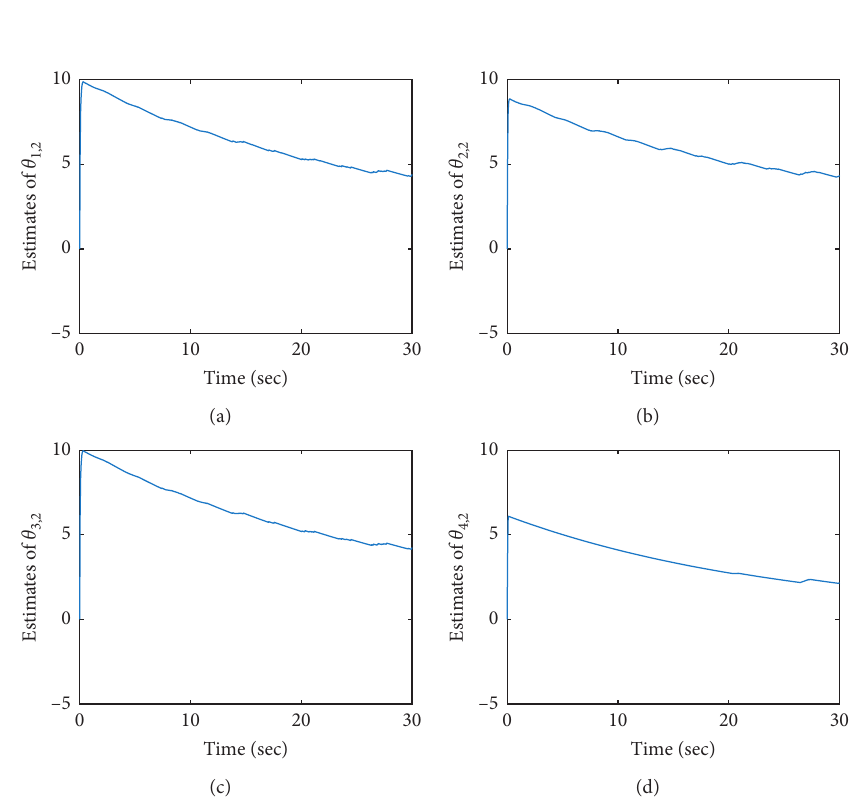
Figure 9: The adaptive laws 􏽢 θ